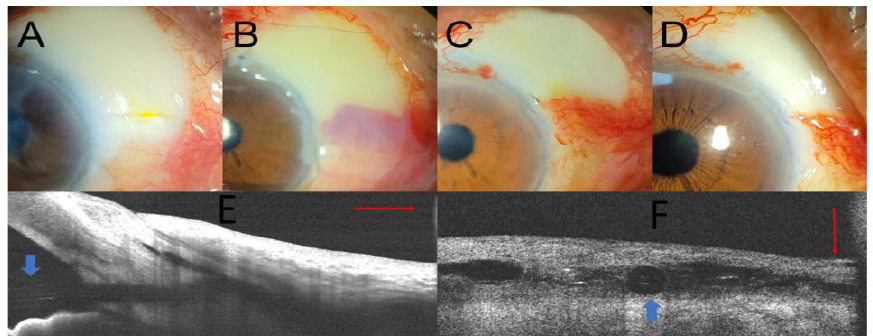
Figure 5. Preoperative anterior segment photography ( A ) and postoperative photographs on day 10 and at 1 month and 3 months ( B – D ). AS-OCT ( E , F ) demonstrated the well-covered conjunctiva over the XEN gel stent postoperatively after 1 month (blue arrow: XEN gel stent implant; red line: linear scan line on AS-OCT).